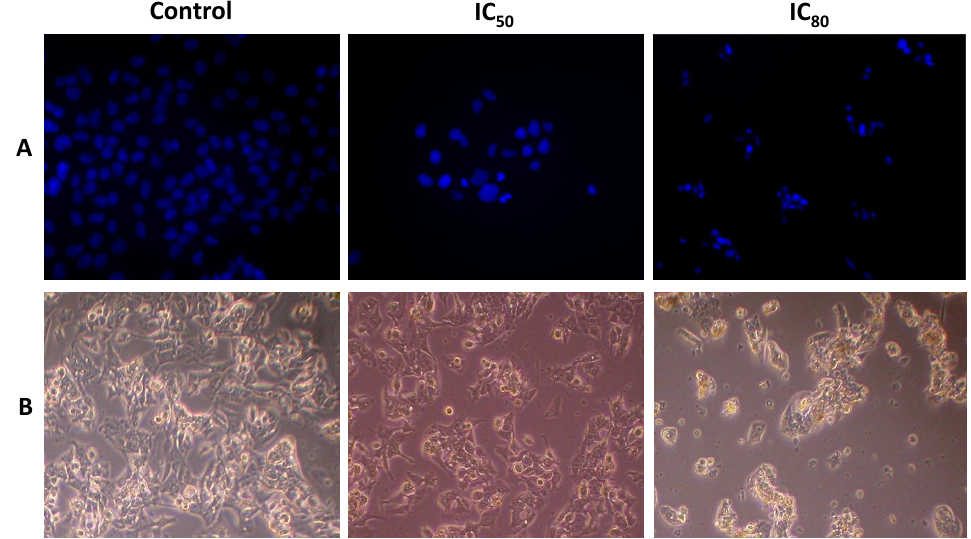
Figure 8. Morphological changes in HepG2 cells after exposure to OADP for 72h, at IC 50 and IC 80 concentrations. Cells were examined using fluorescence microscopy with a DAPI filter, following Hoechst-stained as described in the Section 2 ( A ). Phase-contrast light microscopy cell images ( B